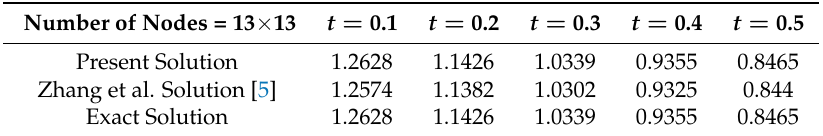
Table 4. Numerical solution of ρ ( x , y , t ) at x = 0.5, y = 0.5 compared with exact solution and Zhang et al. [5] (Example